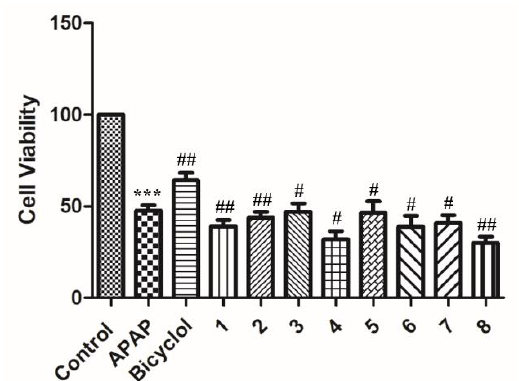
Figure 5. Hepatoprotective effects of compounds 1 – 8 against N -acetyl- p -aminophenol (APAP)-induced HepG2 cell injury.